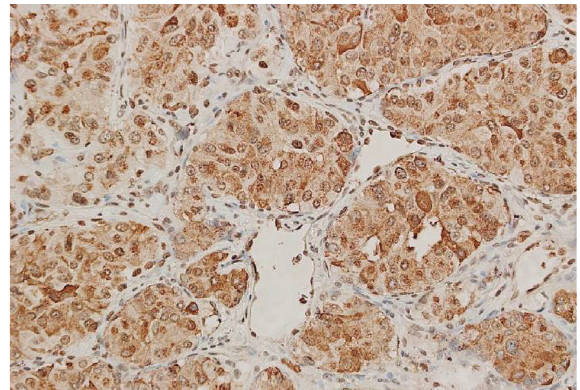
Figure 4: Cardiac paraganglioma histology. Chroma ffi n cells positive with chromogranin-positive immunohistochemistry